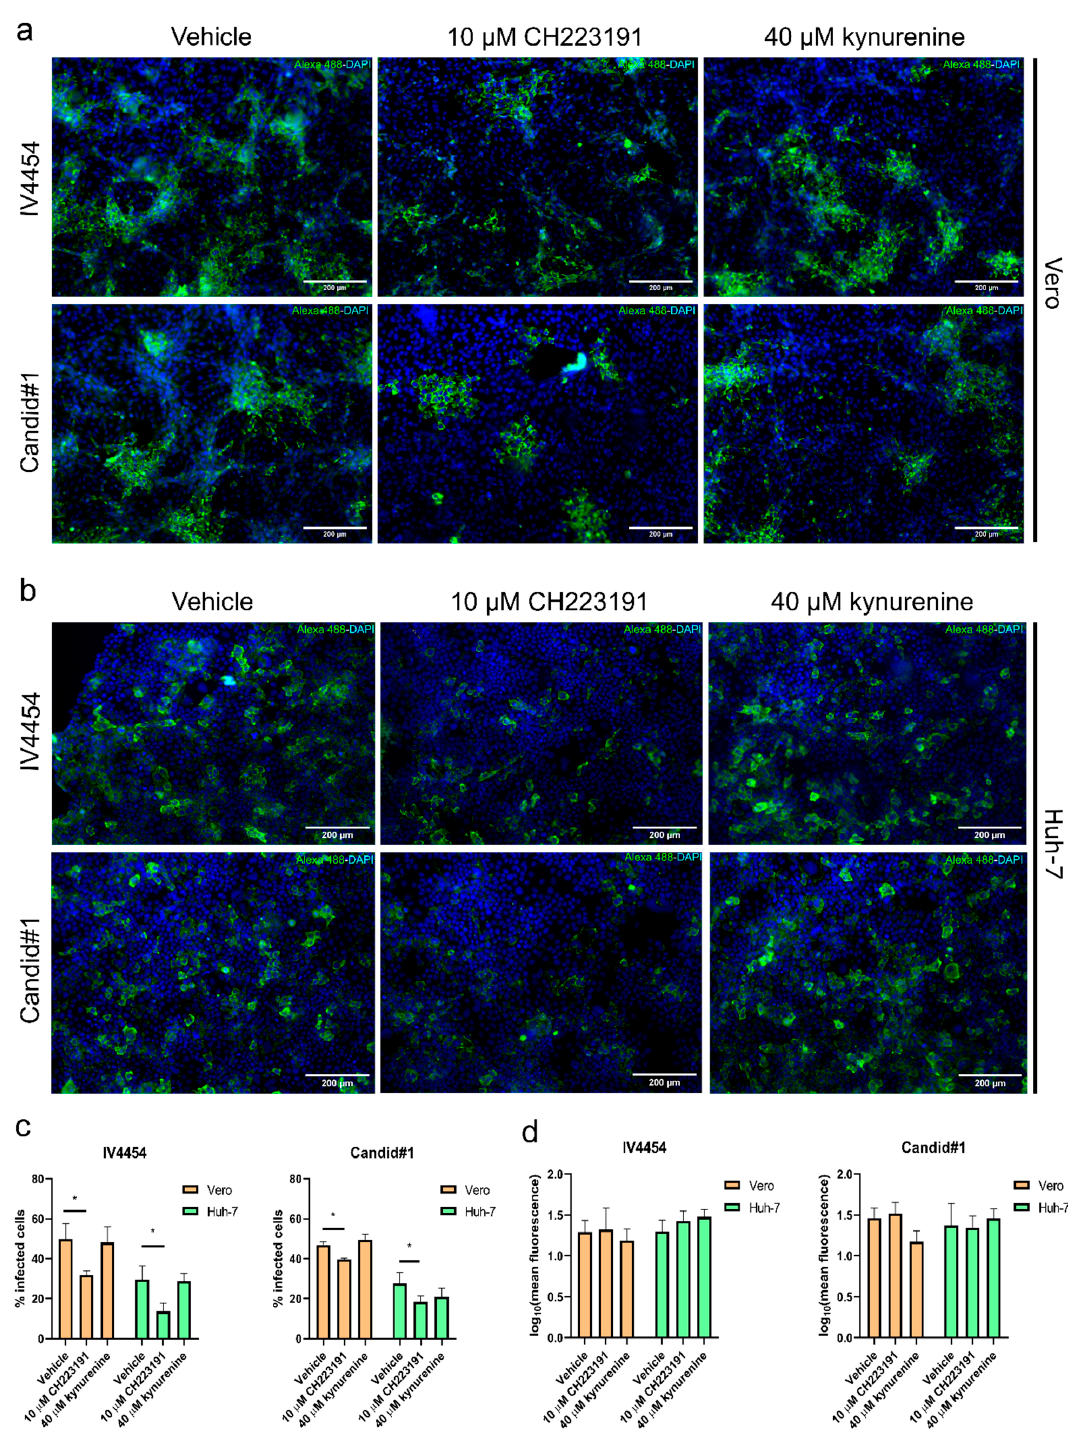
Figure 5. AHR impacts on JUNV protein expression. Vero ( a ) and Huh-7 ( b ) cells were infected with either IV4454 or Candid#1 (MOI = 0.5) for 48 h. Then, cells were fixed and processed through immunofluorescence. NP was stained with Alexa 488 (green), and cell nuclei were stained with DAPI (blue). Scale bar: 200 µm. Magnification: 600X. ( c ) Quantification of NP-positive cells. Results were shown as % of infected cells (% of NP-positive cells). Quantification was performed for over 200 cells per condition. ( d ) Quantification of mean fluorescence intensity of individual cells (100 cells) per treatment. Results were plotted as the mean ± SD. Statistical analysis was performed by comparing treatments with vehicle control. * p < 0.05 was considered statistically